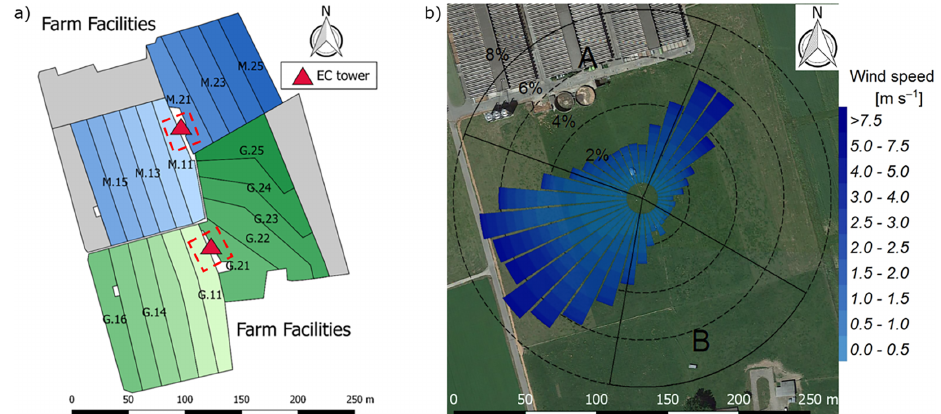
Figure 1. (a) Measurement site with the pastures for the two herds (blue: grass diet with additional maize silage; green: full grazing regime; grey: optional pasture areas) and the division into the paddocks (M.11–M.25, G.11–G.25). Additionally the location of the two EC towers (triangles) and the area of the chamber measurements (red dashed rectangles) are shown. (b) Wind distribution for the northern sonic anemometer with the corresponding sector contributions (black dotted circles) for the period May–October 2016. The areas A and B indicate wind sectors from which advection from nearby farm building can occur. The wind distribution was overlaid on a Google Earth image of the experimental area (map data: Google,